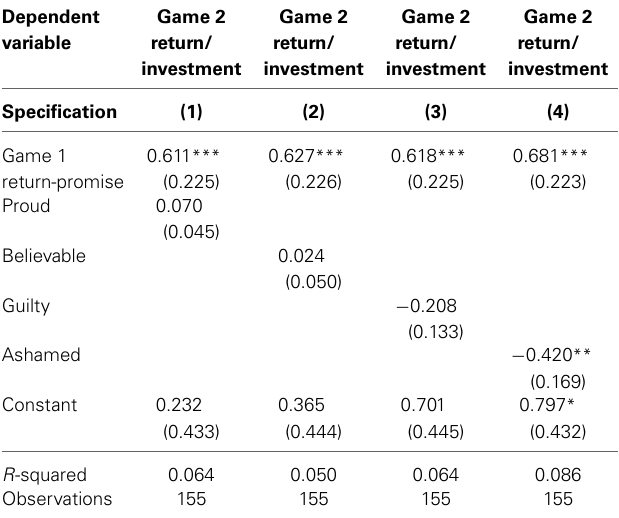
Table 9B | Regression of game 2 Signal Value on promise keeping trustees’ emotions.